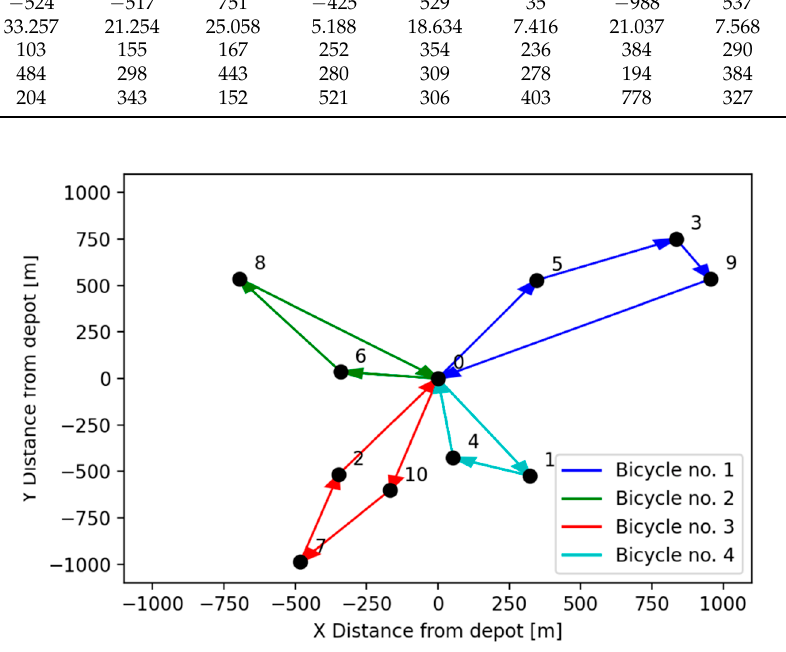
( b ) Figure 2. Histograms for all Bin Pack routes according to ( a ) time and ( b ) distance. All TSP-optimal routes for all knapsacks have a mean time of 2780 s, maximum spread is 855 s and standard deviation of population is 164 s. All 2D feasible solutions count was 827,772. They were calculated in 565 s. There were 41,253,456 route permutations, which were calculated in 298 s. Total algorithm runtime was 864 s. Average time of all 2D feasible routes was 2168 s with population standard deviation of 168 s and range of 1105 s. Mean distance of all 2D feasible routes was 11,325 m with population standard deviation of 991 m and range of 6290 m. This algorithm managed to find optimal route [[0, 0, 3, 5, 9], [0, 0, 6, 8], [0, 0, 2, 7, 10], [0, 0, 1, 4]] with total travel time of 1525 s and total travel distance of 7914 m. Distance of optimal solution was also the minimum of all feasible distances.